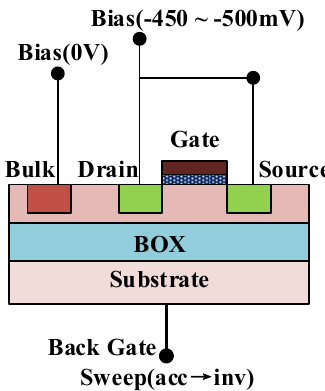
Figure 1. A two-dimensional (2-D) structure and the DCIV measurement setup of the SOI NMOSFETs. Figure 1. A two − dimensional (2 − D) structure and the DCIV measurement setup of the SOI NMOSFETs.